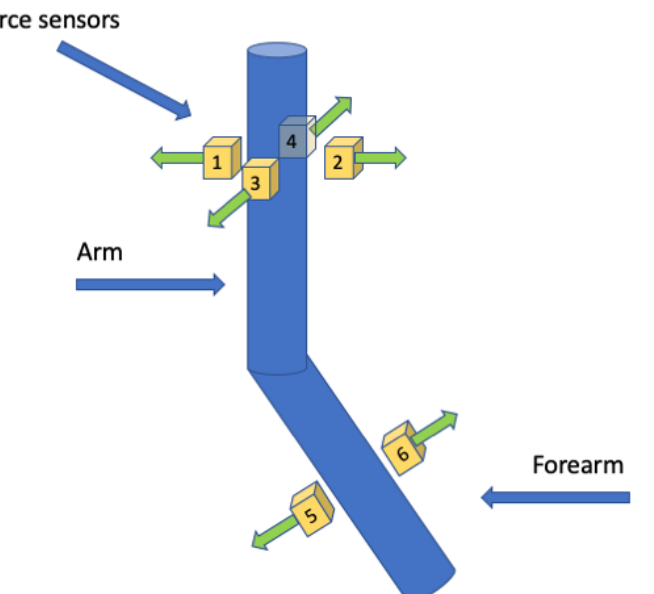
Figure 3. Prototype of an exoskeleton with three degrees of mechanical freedom: ( a ) side and ( b ) front view.